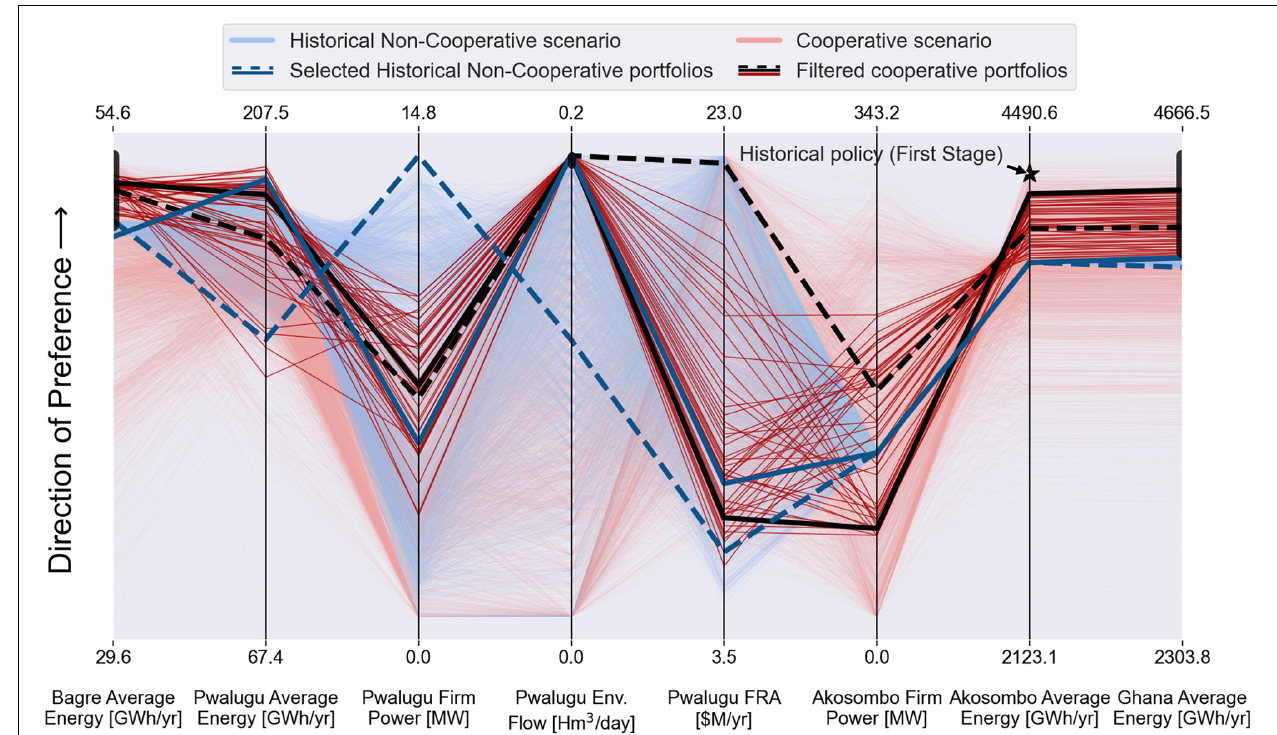
FIGURE 5 | Parallel axis plot comparing the historical non-cooperative and cooperative scenario. Light blue and light red are the full set of non-dominated solutions for the historical non-cooperative and cooperative scenario, respectively. Blue solid and dashed lines are selected portfolios of the historical non-cooperative scenario and the black and solid red lines are filtered portfolios of the cooperative scenario. Vertical thick black bars over parts of the first, fourth and eighth axes are “filters” which allow selecting a subset of the efficient designs in the plot. The Akosombo average energy [4,457.8 GWh year − 1 ] of the historical policy, identified in the First Stage, is shown with a black